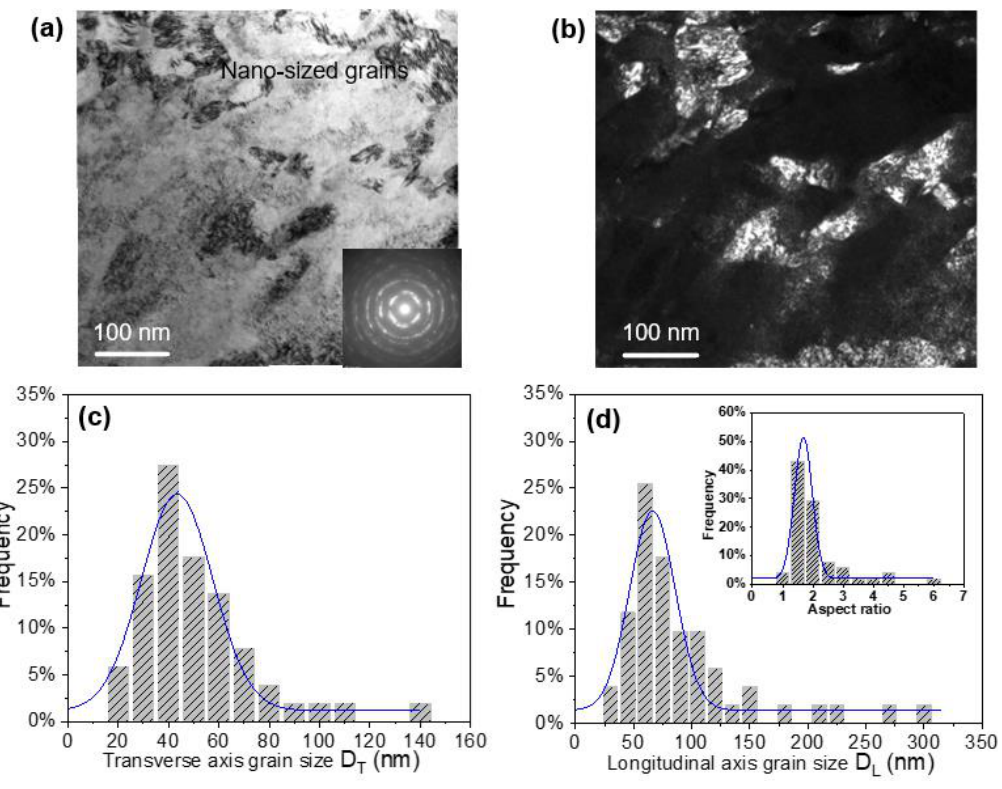
Figure 4. TEM observations and statistical distribution of grain size in the top surface layer of SMCGT sample: ( a ) bright field image; ( b ) dark field image; ( c ) transverse axis grain size (D T ); and ( d ) longitudinal axis grain size (D L ) (inset: aspect ratio (D L /D T ) distribution).